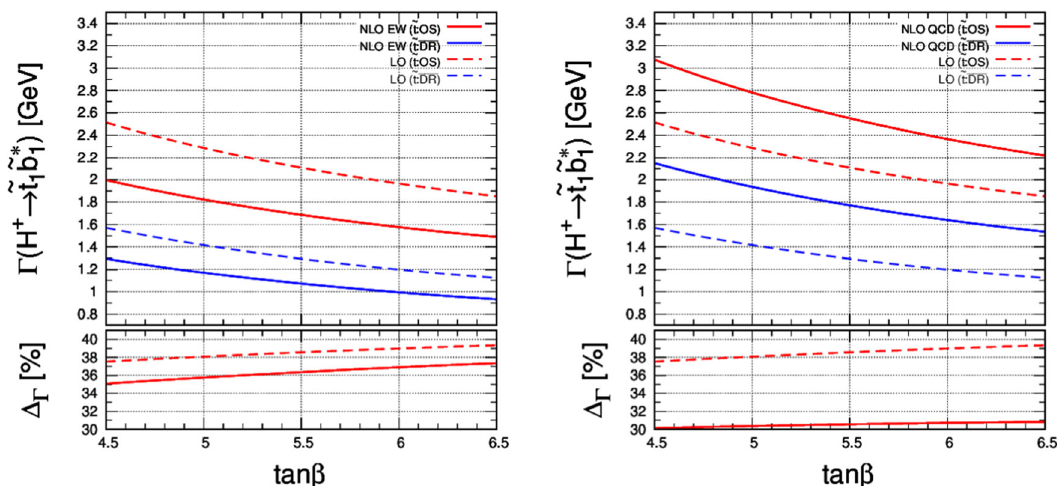
Fig. 10 The partial decay width for the decay H + → ˜ t 1 ˜ b ∗ tion of tan β for OS (red) and DR (blue) renormalization in the stop sector at LO (dashed) and NLO (full) for the SUSY-EW (left) and the